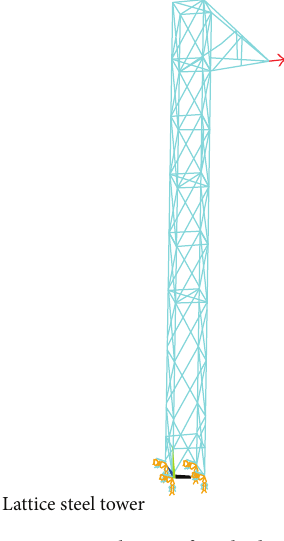
Figure 9: FE simulation of studied tower